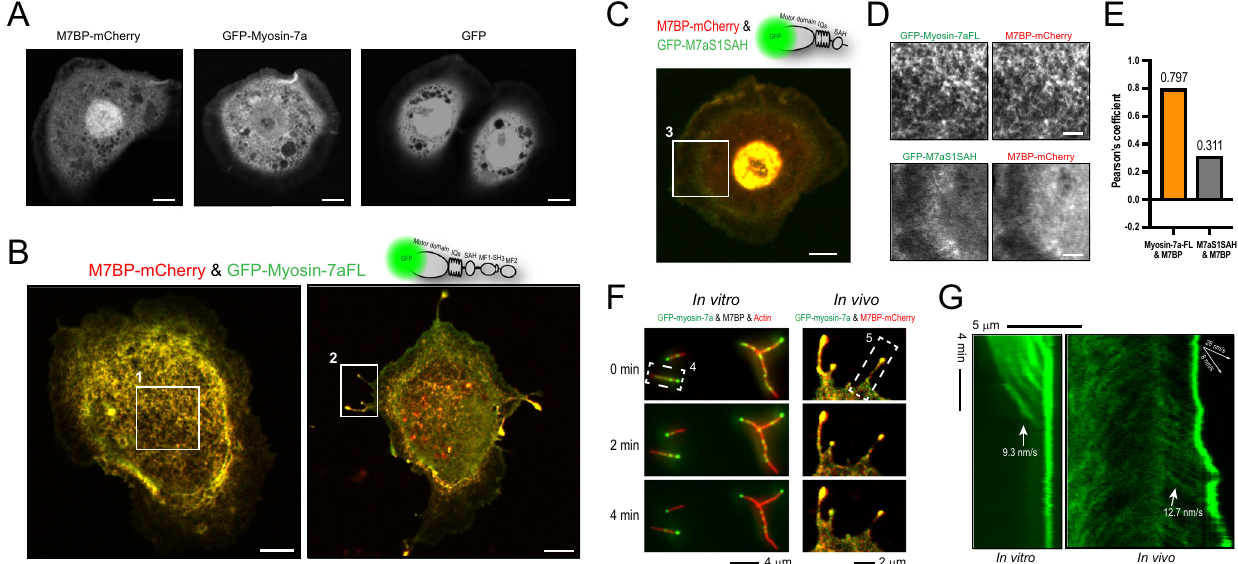
Fig. 5 Expressing myosin-7a-M7BP complexes in cells produces substantial fi lamentous networks and fi lopodial protrusions. A S2 cells transfected with M7BP-mCherry or GFP-myosin-7a alone show no discernable difference in cell morphology compared to that of GFP transfection. Scale bar = 5 μ m. (representative of fi ve independent experiments) B Co-transfection of GFP-myosin-7a (green) with M7BP-mCherry (red) results in the induction of an extensive fi lamentous structure throughout the cell body and the extension of fi lopodial protrusions. Scale bar = 5 μ m. Images are representative of 12 independent transfection experiments. C Co-transfection a monomeric tailless myosin-7a (GFP-M7aS1SAH, green) with M7BP-mCherry (red) does not induce the fi lopodia or the fi lamentous network phenotypes observed in B . Scale bar = 5 μ m. (representative of four independent experiments) D Magni fi ed images of box 1 in B (top panel) and box 3 in C (bottom panel) show that full-length myosin-7a and M7BP are colocalized on the fi lamentous structures, whereas M7aS1SAH and M7BP are diffusive and non-colocalized within the cell. Scale bars = 2 μ m. E Colocalization analysis of regions from box 1 and box 3 yielded high degree of colocalization correlation between full-length myosin-7a and M7BP in contrast to the low colocalization score between M7aS1SAH and M7BP. N = 9802 pixels from ROI 6 × 12 μ m. F Movie frames taken from in vitro single-molecule motility assays (left) and in vivo live cell imaging of a fi lopodium (right) show that myosin-7a-M7BP complexes stay for long duration at the end of actin fi laments. G Kymographs of box 4 and 5 in F show that myosin-7a-M7BP complexes (green) travel with comparable speed in vivo along fi lopodia as they do in vitro along fi xed actin fi